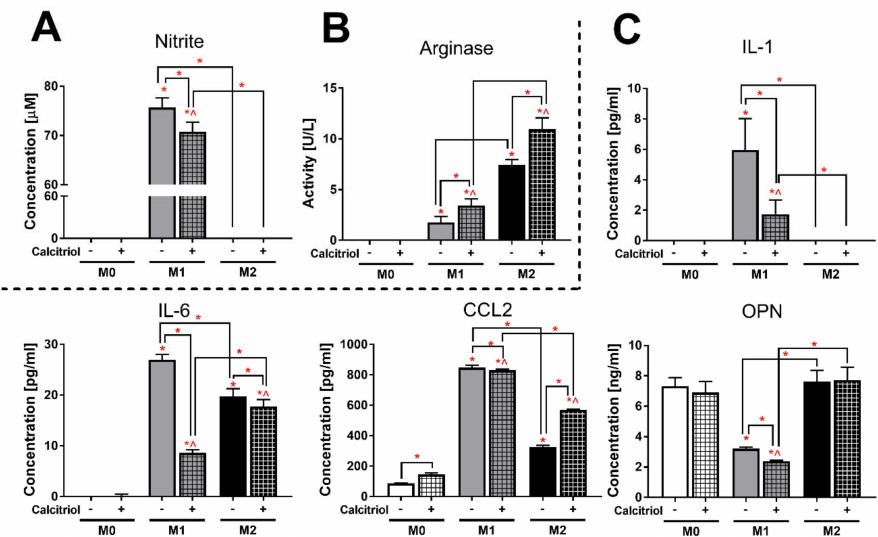
Figure 4. Determination of the e ff ect of calcitriol on the level of expression of markers describing individual BMDMs classes: ( A ) nitrite ion measurement by Griess assay, ( B ) arginase activity assay, and ( C ) measurement of IL-1, IL-6, CCL2, and OPN concentrations by ELISA. Calcitriol lowers the concentration of nitrite ion, OPN, IL-1, and IL-6 in M1 BMDMs. Calcitriol enhances arginase activities for M1 and M2 BMDMs and secretion of CCL2 in M2 BMDMs. ELISA assays and measurement of arginase activity and nitrite ions concentration (Griess assay) were performed according to the manufacturers’ protocols. Data presentation: mean with standard deviation. Number of independent repetitions = 3 ( C ) or 4 ( A , B ) (BMDMs cultures generated from three or four mice). Statistical analysis: Sidak’s or Dunn’s multiple comparisons test. * p < 0.05 as compared to M0, ˆ p < 0.05 as compared to M0 + cal or as indicated.